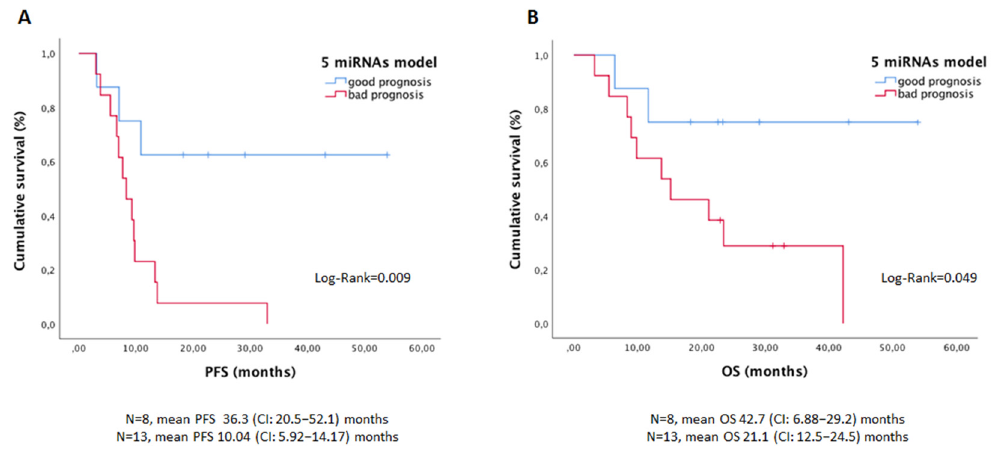
Figure 5. Kaplan–Meier curves to predict PFS ( A ) and OS ( B ) according to the five-miRNA model in stage IV CRC patients. Note: PFS, progression-free survival; OS, overall survival; CI, confidence interval.